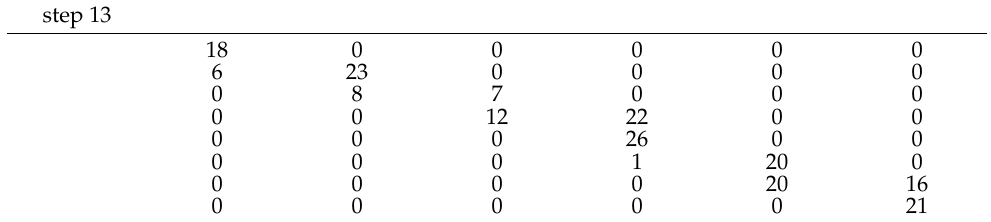
Table 4. Results of subsequent iterations and feasible solution for northwest corner method.